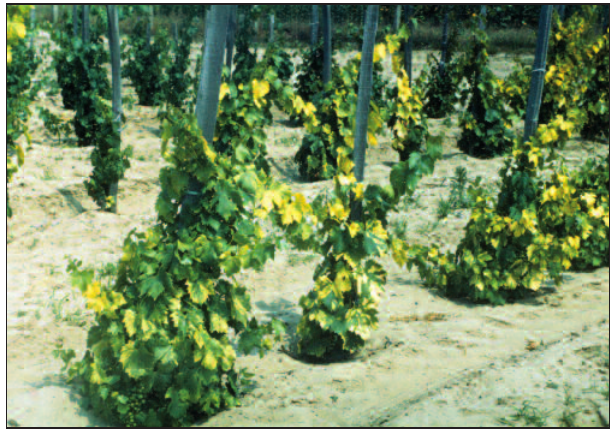
Figure 2. Fanleaf – chromogenic virus strain (GFLV-YM): bright yellow discolourations of the